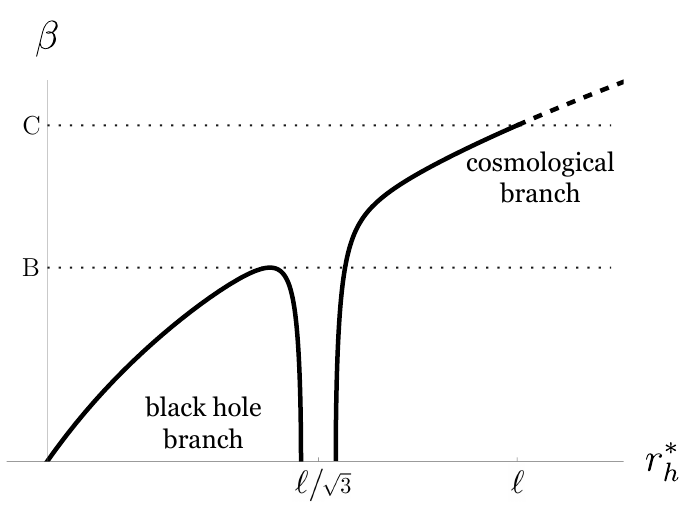
Figure 7. The inverse temperature β as a function of the horizon radius for the black hole ( r ∗ ) and b cosmological ( r ∗ ) solutions, as given by (3.27), for any boundary sizes 0 < R < ‘ (here R = 0 . 54 ‘ ) c √ √ except the special value R = ‘/ 3 (the β and r ∗ axis scales differ). When R = ‘/ 3 the two branches h merge in the middle on a vertical line. For β < β B there are three stationary points. The dashed p part of the cosmological branch ( r ∗ > ‘ , β > β C = 2 π‘ 1 − R 2 /‘ 2 ) corresponds to negative mass c parameters, ascending monotonically as M ∗ becomes more